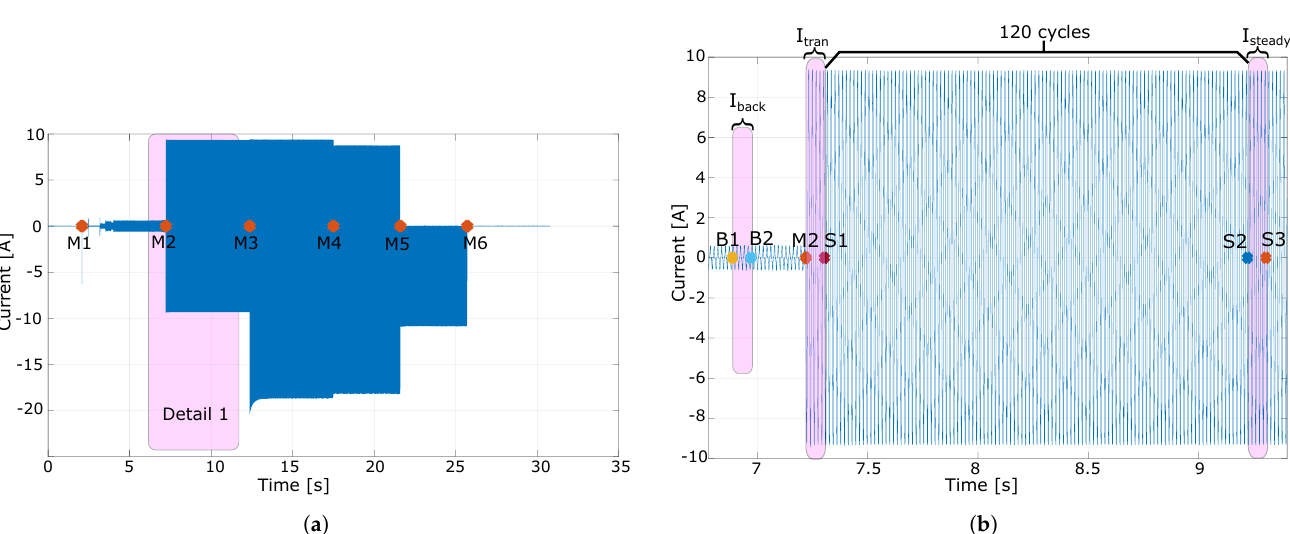
Figure 2. Example of preprocessing and disaggregation. ( a ) An original waveform of LIT-SYN3. Markers in red are load turn-on or turn-off annotations (both considered previously known in our case). ( b ) Detail 1 from ( a ), showing regions where I trans , I steady , and I back are located.